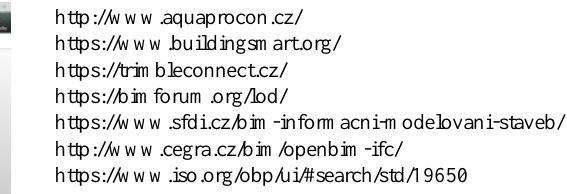
Figure 3. Reinforcement drawings